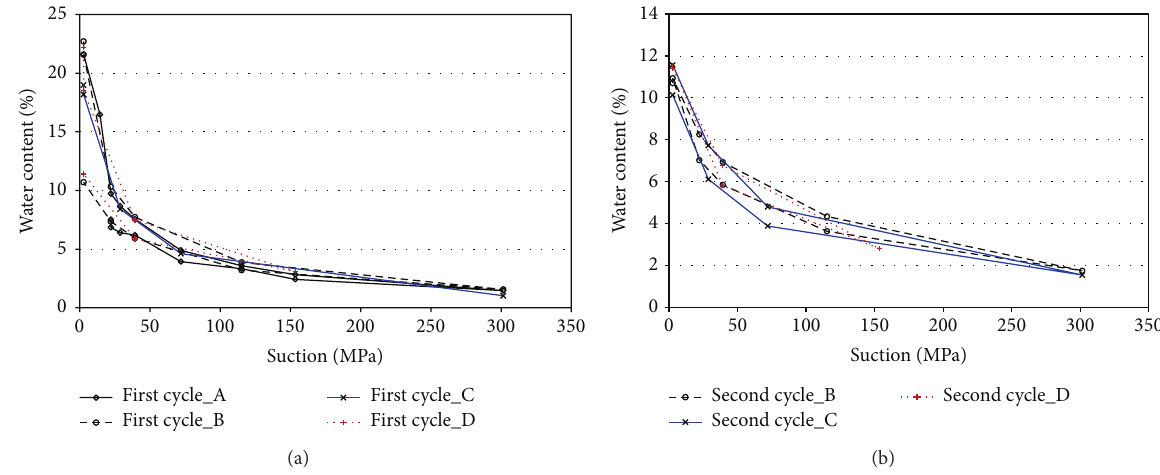
Figure 4: (a) Effect of suction gradient on the water retention curves during the first hydric cycle and (b) the second hydric